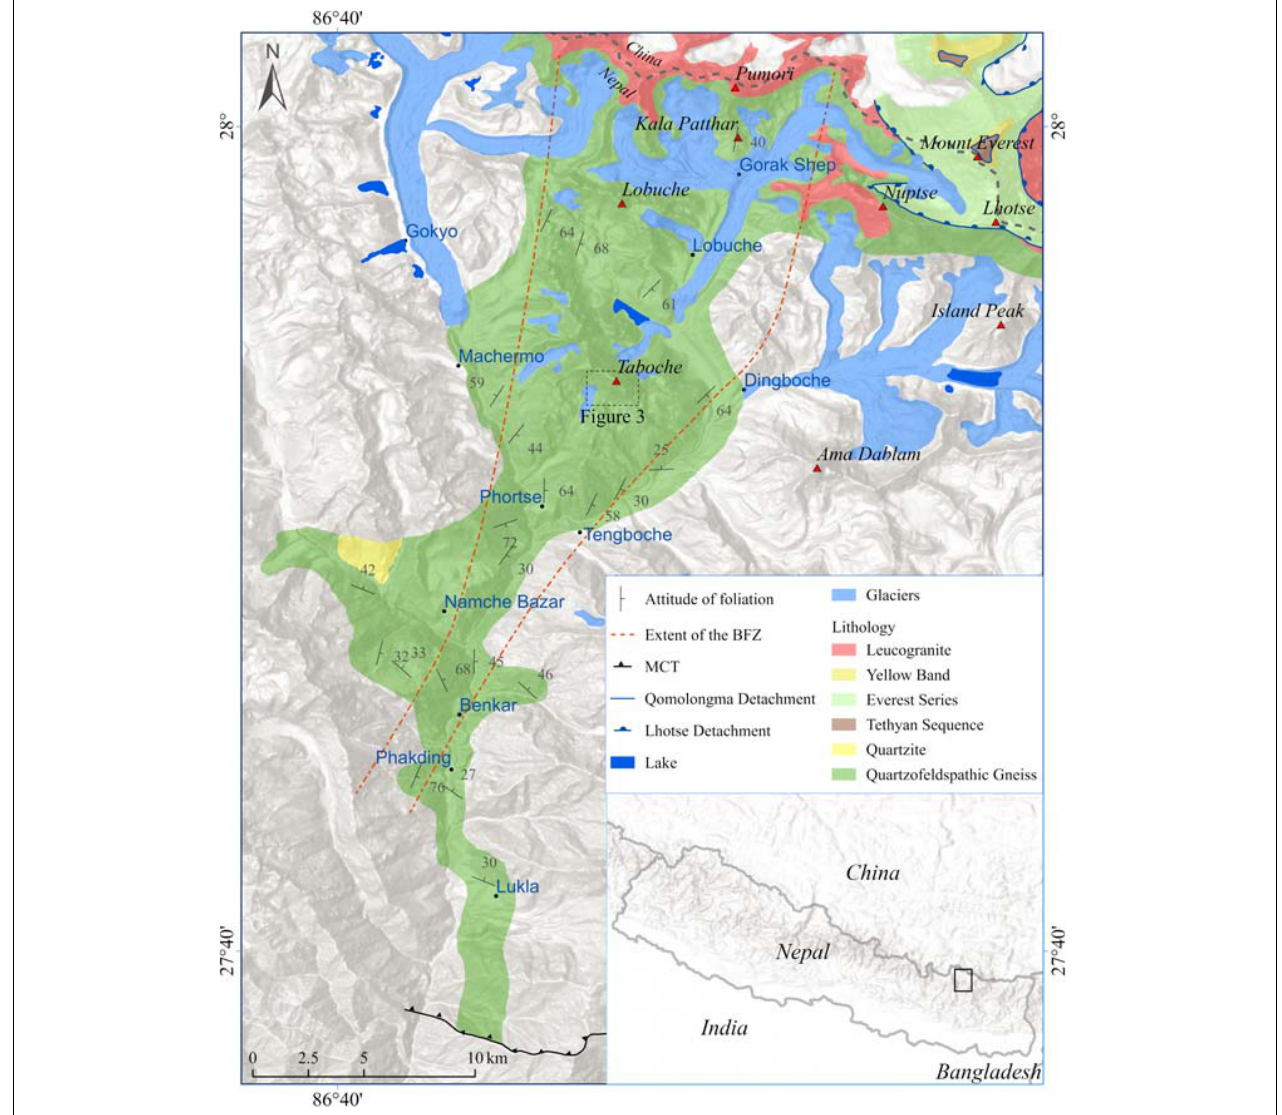
FIGURE 4 | Simplified geologic map of the northern Benkar fault zone. The dotted lines outline the region of non-penetrative, NE-striking shear fabric of the Benkar Fault zone. Kinematics on this shearing are dextral, normal. MCT: Main Central Thrust (after: Seifert,